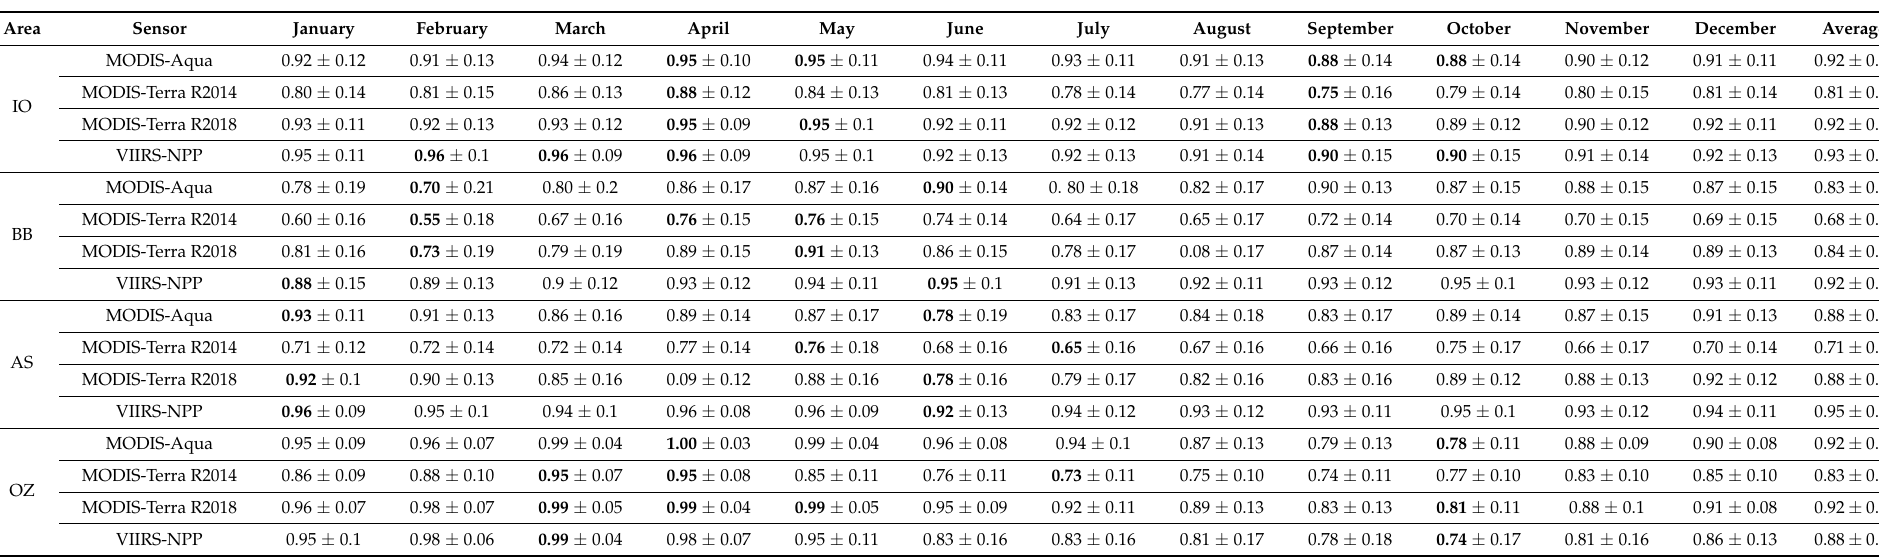
Table 1. Scores and their standard deviations over the study area of MODIS-Aqua, MODIS-Terra (Versions R2018 and R2014) and VIIRS-NPP level 3 R rs ( λ ) monthly products based on quality assurance (QA) method (Formula (1)), with 1 for a perfect spectrum and 0 for an unusable spectrum. Numbers in bold are the annual maximum and minimum of monthly scores. IO, BB, AS, and OZ represent the Indian Ocean, Bengal Bay, Arabian Sea and oligotrophic gyre zone in the southern Indian Ocean,